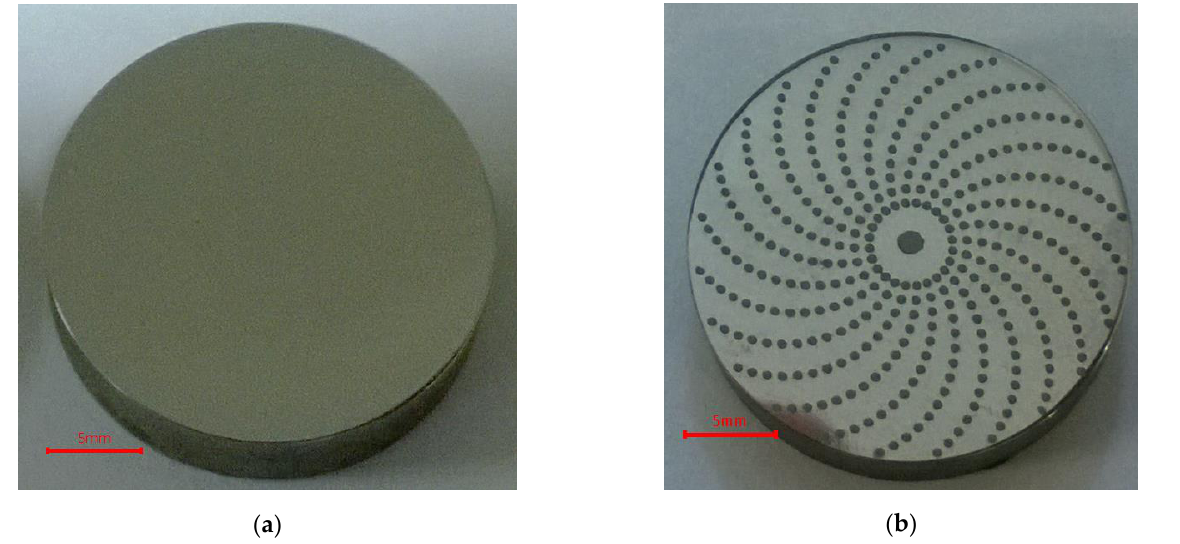
Figure 9. Photos of examples of ( a ) untextured and ( b ) textured discs. Tests were carried out using a pin-on-disc tribotester T-11. Tests were performed with normal loads of 20 and 40 N. Rotational speed changed during the test from 100 to 1000 rpm with a step of 100 rpm. The test duration was 600 s, and the sliding distance was 276.5 m. The friction radius was 8 mm for all tests. The number of test repetitions was three. Figures 10 and 11 show the average values of the coefficients of friction and scatters for various rotational speeds for loads of 20 and 40 N, respectively. The